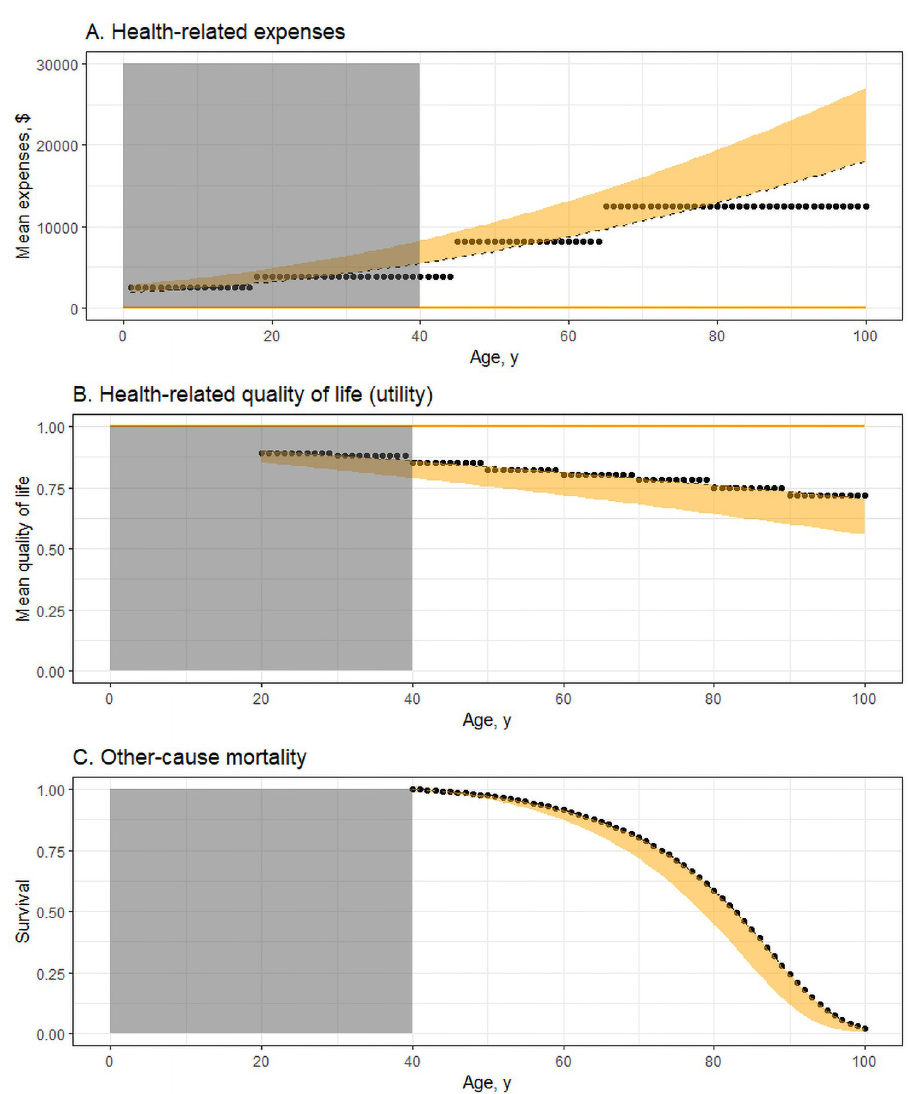
Fig 1. Model assumptions on health-related expenses, quality of life, and mortality by age. a a Dots represent observed data; black dashed lines fitted using weighted nonlinear least squares regression; yellow ranges alternative assumptions evaluated in this study (incl. zero costs and disutility). Observed data in Panel A are estimated health- related expenses by age from the Medical Expenditure Panel Survey [19]. Observed data in Panel B estimate the health- related quality of life (utility) [20]. Survival rates in Panel C are derived from U.S. life